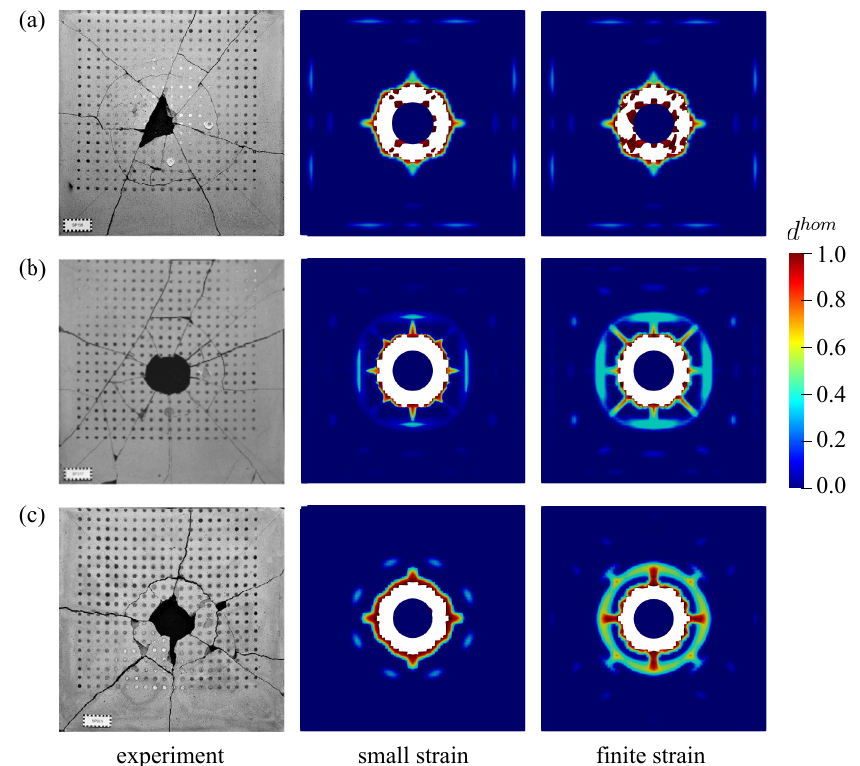
Figure 26. Top view of thin plate impact test for experiments in [48] comparing small and finite strain simulations at three different velocities: ( a ) 12.3 m/s, ( b ) 16.5 m/s, and ( c ) 20.3